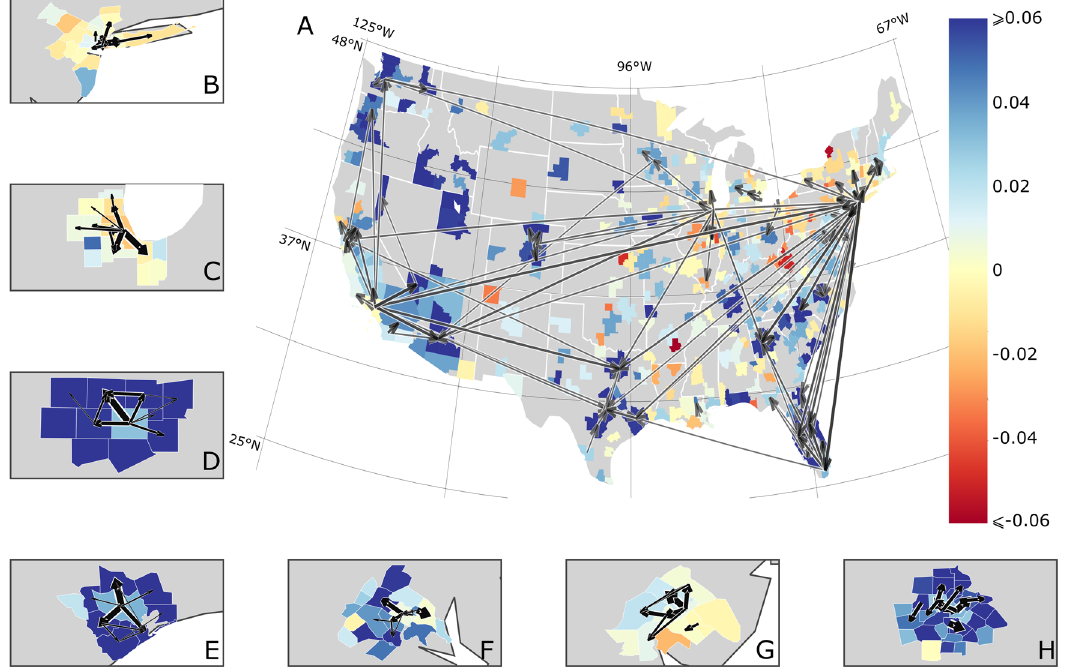
Fig.2|Heterogeneityofinter-andintra-citynet fl ows. Themap( A )suggeststhat the domestic redistribution of people between different U.S. metro areas are non- uniform: the black arrows, indicating the direction of the most intense inter-city net fl ows (higher than 2000 people per year), reveal migration trends from north- ernand easterncitiestowesternand southernregions.Cities(composed of one or more counties) are colored according to the relative growth (viz. population growth adjusted by population) of the whole MSA during the 2015 – 2019 period, and the black intensity and the thickness of the arrows are proportional to the